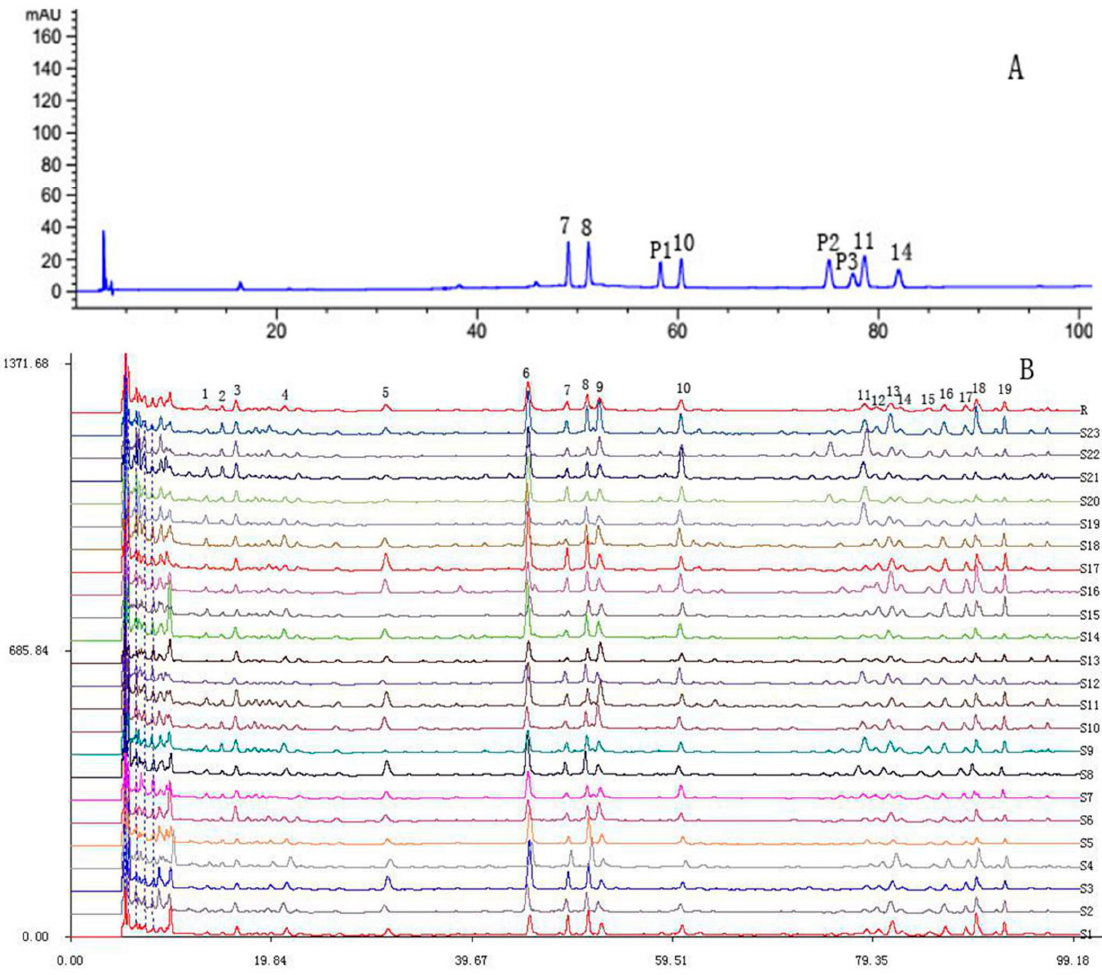
Figure 4. ( A ): 7 Deapioplatycoside E; 8 Platycoside E; P1 Deapioplatycodin D 3 ; 10 Platycodin D 3 ; P2 Deapioplatycodin D; P3 Platycodin D 2 ; 11 Platycodin D; 14 Polygalacin D; ( B ): The chromatographic fingerprint of PR from 23 locations.